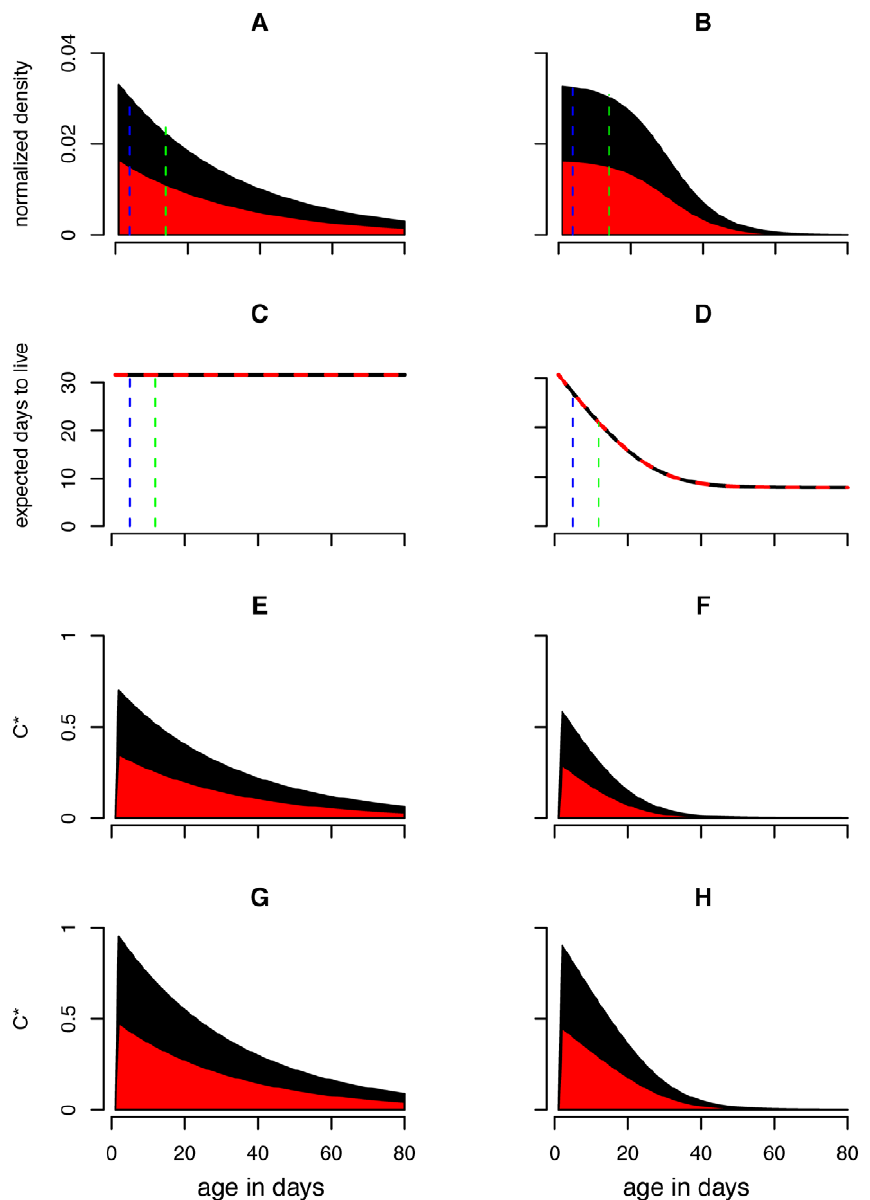
Figure 4. Effects of reduced recruitment on demography and vectorial capacity. The above figure displays the effects of reduced recruitment ( r L =0.5, red) compared to a baseline scenario ( r L =0, black) on the mosquito population distribution (A,B), the life expectancy function (C,D) and the scaled-vectorial-capacity-contributions by age class for extrinsic incubation periods (EIP) of 12 days (E,F) and 2 days (G,H). The left column of panels (A,C,E,G) displays results from the constant mortality model while the right column of panels (B,D, F, H) show results from the age dependent mortality model. The green and blue dashed lines in the first two rows indicate EIPs of 12 and 2 days, respectively. Because C* can be calculated by summing across ages old enough to be infectious the product mosquito density and life expectancy (Equation 12), these dashed lines can be used to visually inspect how the first two rows of panels yield the second two panels. Note that, unlike reducing mosquito survival (Figure 3), reducing mosquito recruitment by half reduces scaled vectorial capacity ( C* ) by half in regardless of the hazard model or EIP.